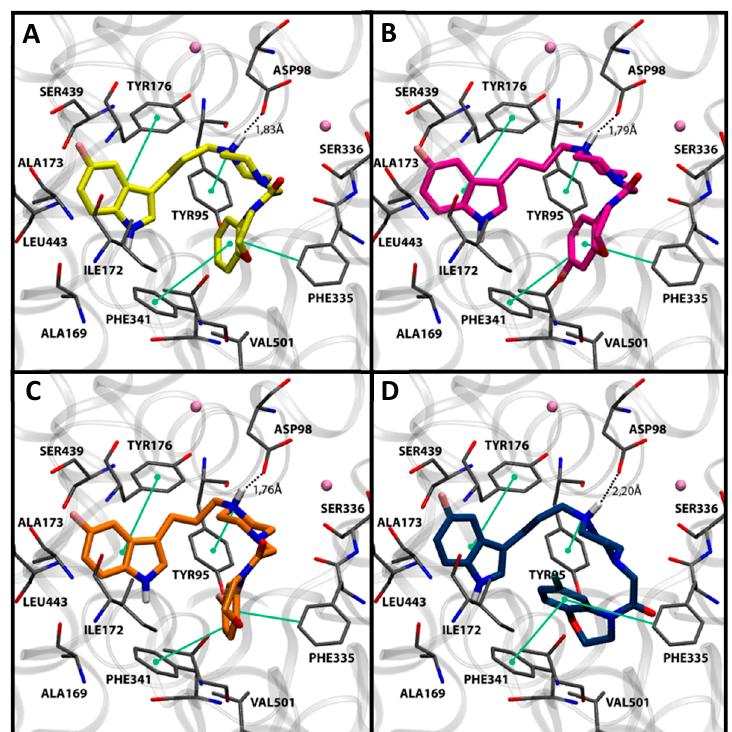
Figure 1. Docking poses in SERT obtained for compounds 7g ( A ) in yellow, 7h ( B ) in magenta, 7i ( C ) in orange, and 7k ( D ) in blue. Nearby residues <5Å (grey sticks) and Na + atoms (pink spheres) are shown. Dotted lines represent ionic interactions and aromatic interactions are shown with green lines.